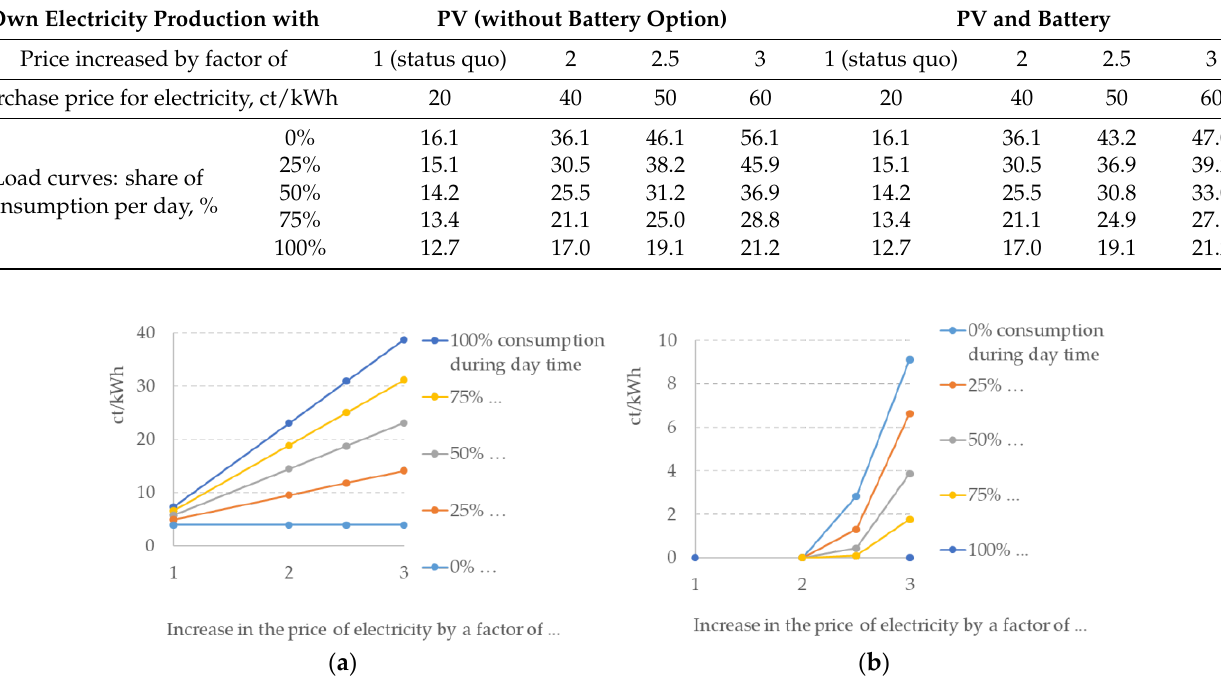
Table 7. Costs of farm’s power supply.